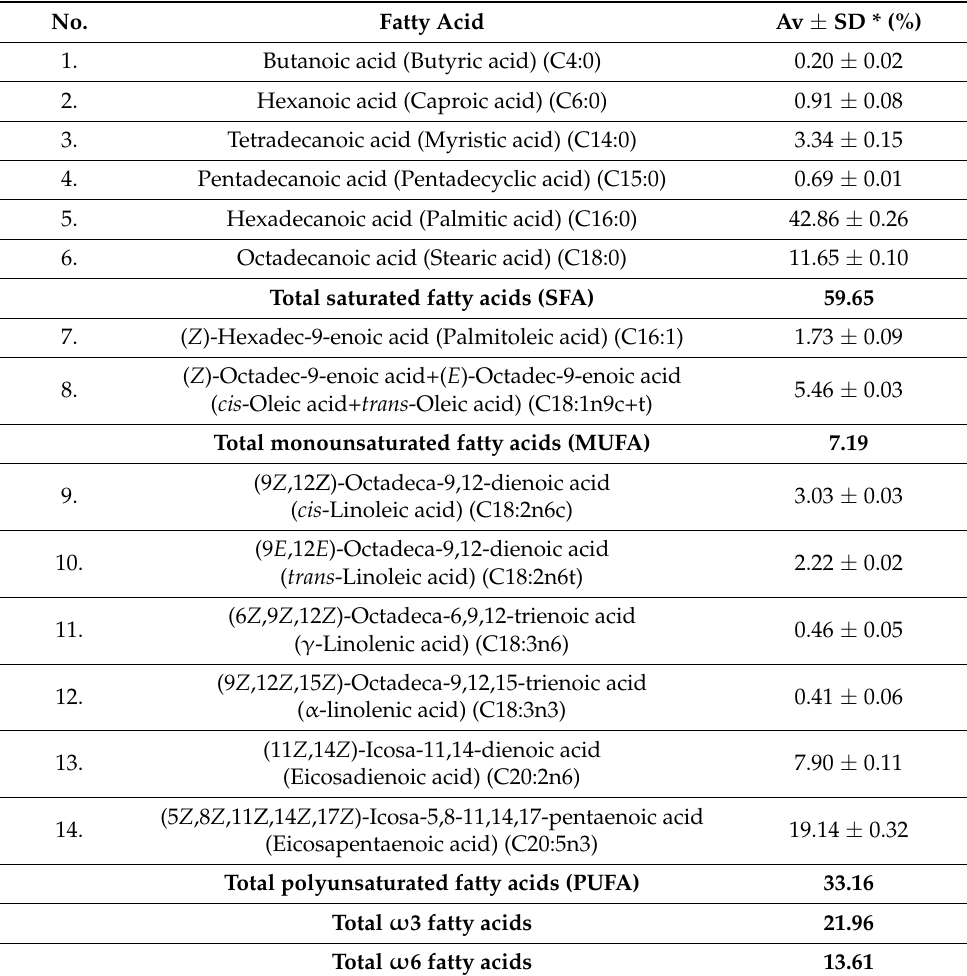
Table 3. Fatty acids composition of A. rigida determined by